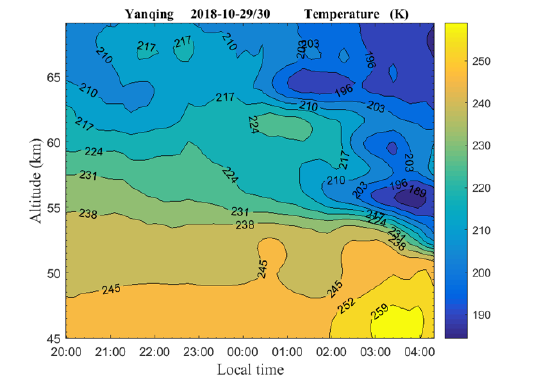
Fig. 4 . Time-altitude variation of atmospheric temperature (40-65km) derived from lidar observations at Yanqing (40.5°N, 116°E) before the occurrence of